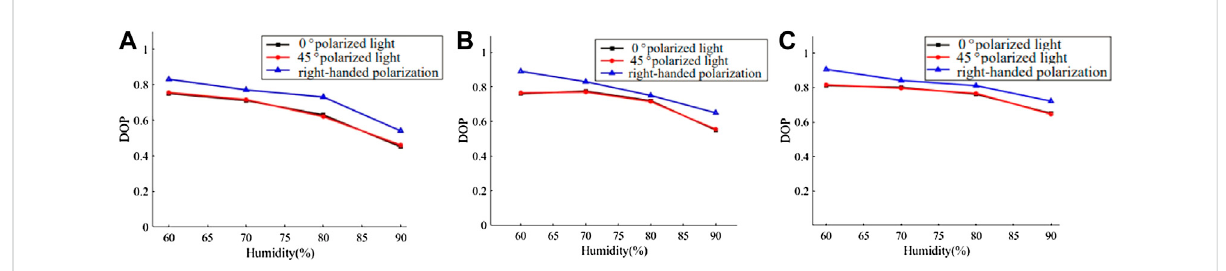
FIGURE 14 The relationship between humidity and degree of polarization at various wavelengths. (A) 450 nm; (B) 532 nm; (C) 671